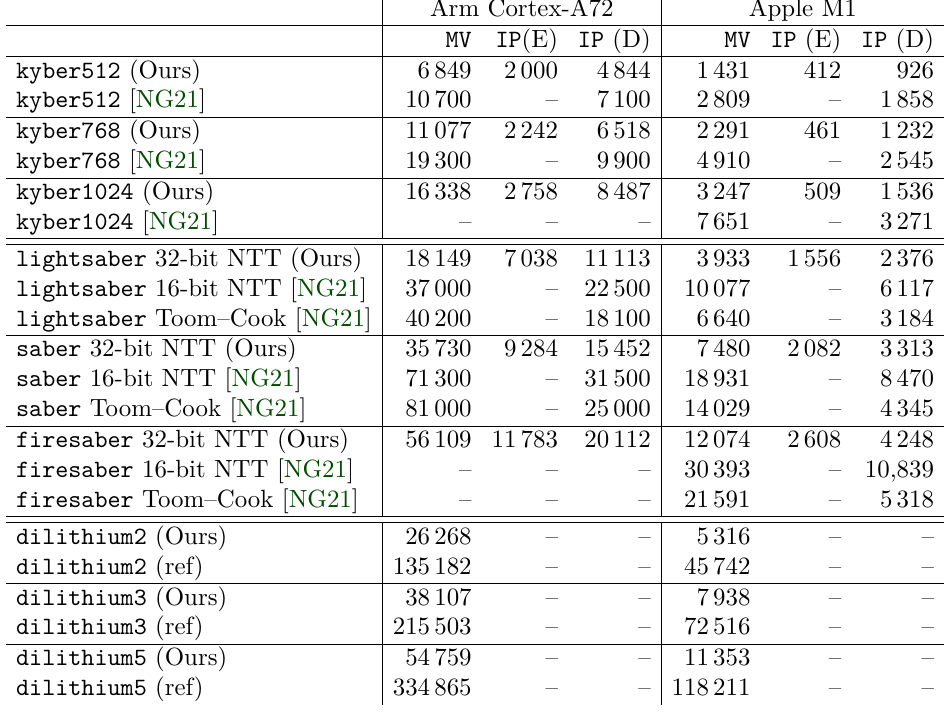
Table 5: Cycle counts for MatrixVectorMul ( MV ), and InnerProd ( IP ) for kyber768 , saber , and dilithium3 on Cortex-A72 and Apple M1. For kyber768 and saber the InnerProd in encapsulation (E) can re-use intermediate results from the MatrixVectorMul ; in decapsulation (D) a full InnerProd is needed. dilithium3 does not use an InnerProd . On Cortex-A72, we report median cycle count of 10 000 executions. On Apple M1, we report the average cycle count of 10 000